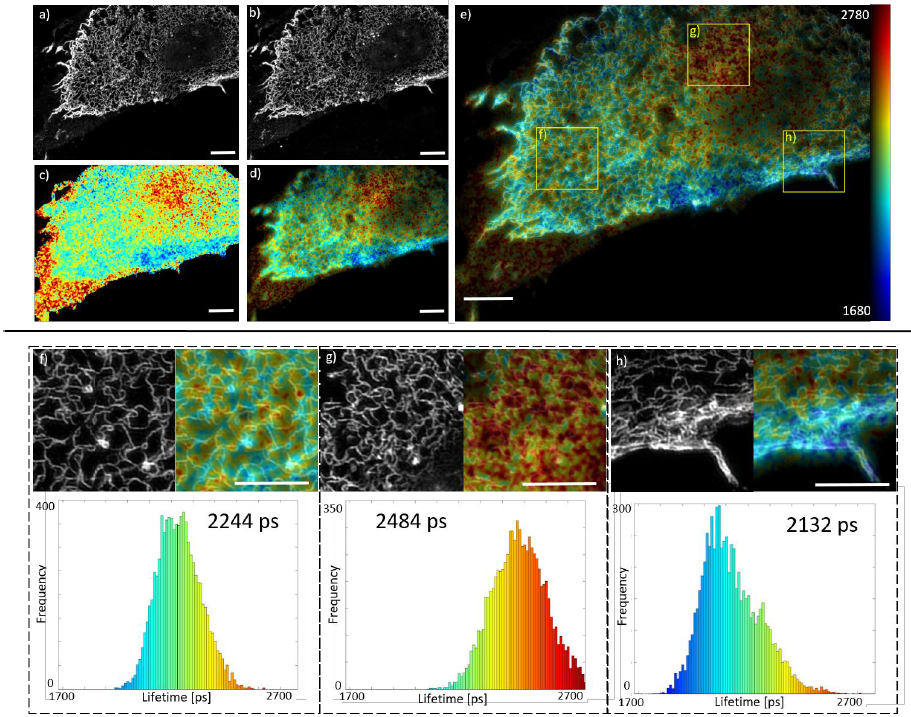
Figure 2. Fluorescence intensity and intensity-weighted lifetime images of the DDR1 receptor expressed in Cos7 cells and labelled stochastically with SNAP-tag-Alexa-488 or SNAP-tag-Alexa-546 and stimulated with collagen. ( a , b ) shows the SIM images of Alexa-488 ( a ) and Alexa-546 ( b ) labelled DDR1 receptors while ( c ) shows the optically sectioned Alexa488 fluorescence lifetime map and ( d ) shows the corresponding intensity-weighted fluorescence lifetime image. ( e ) shows the intensity-weighted Alexa488 fluorescence lifetime image added to the SIM intensity image of ( a ) and ( f–h ) presents sub-regions of ( e ) magnified to show nanostructure with corresponding intensity-weighted lifetime histograms and the intensity-weighted mean fluorescence lifetime values inset (STD can be found in Table 1). (Scale bar: 6 µm).